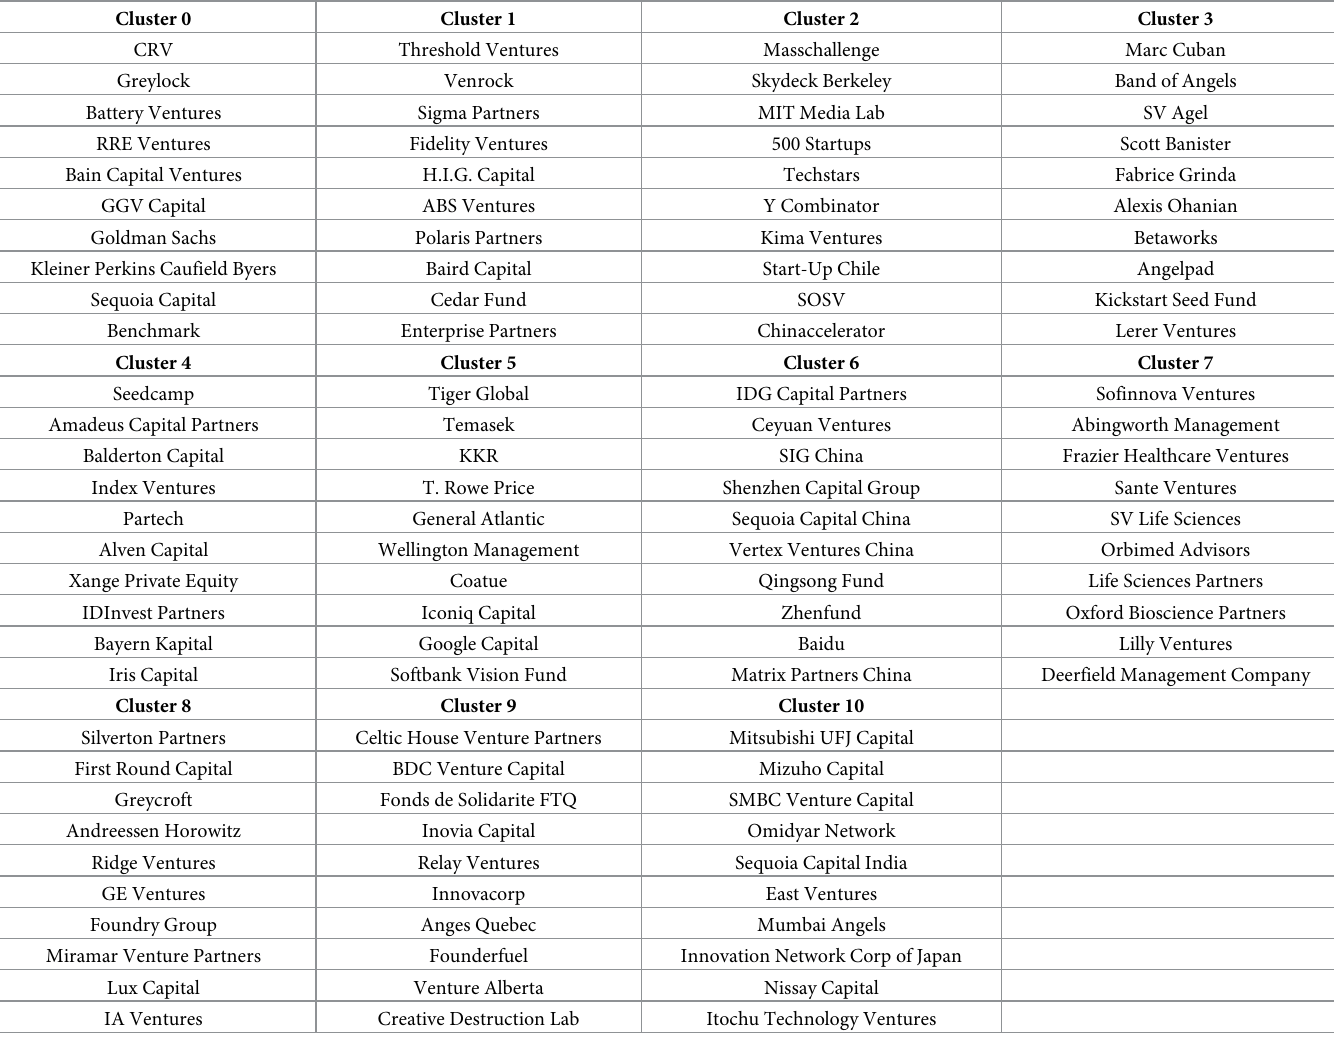
Table 2. Complete clustering: Sample investors from each